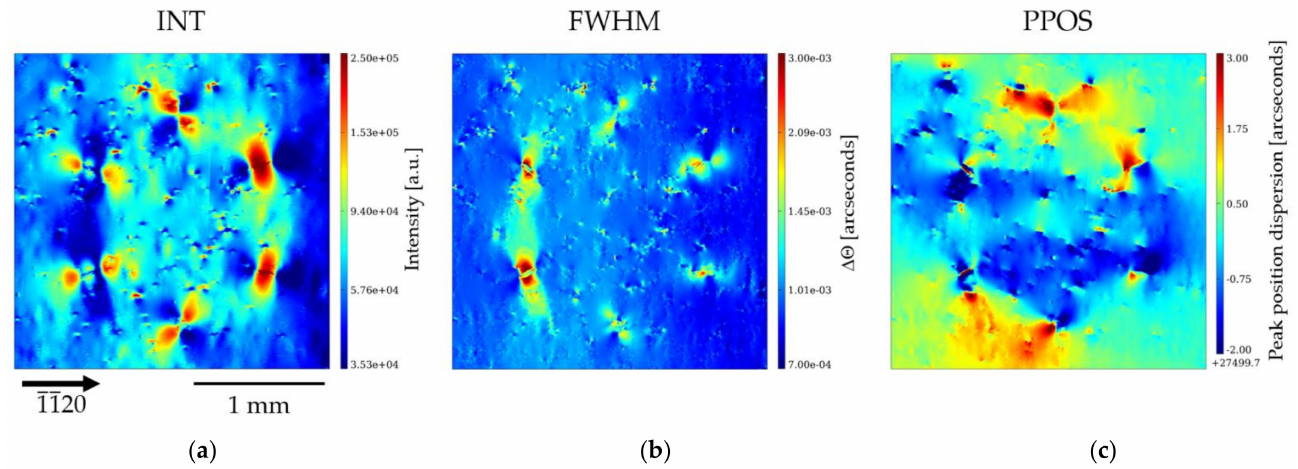
Figure 11. RCI maps of the 1120 reflection at 30 keV: ( a ) integrated intensity map (INT); ( b ) full-width at half-maximum map (FWHM); ( c ) peak position map (PPOS).